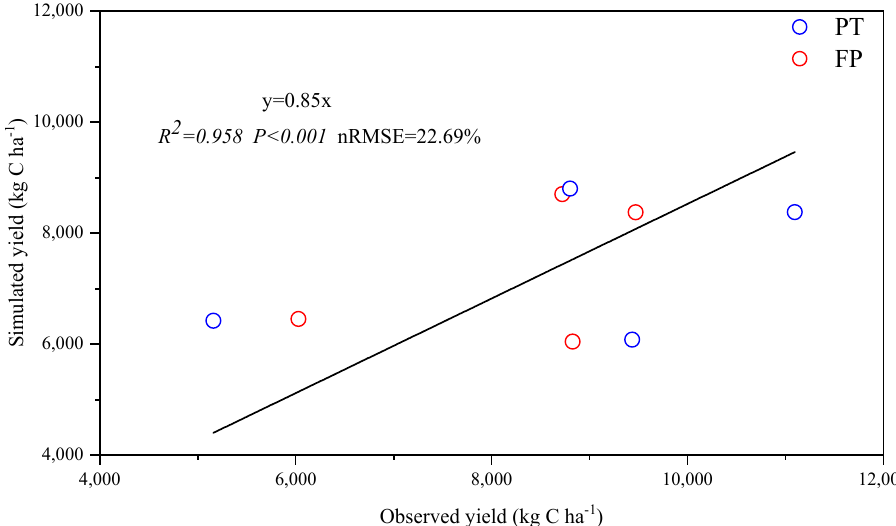
Figure 1. Comparison of simulated and observed yields during 2015 − 2017. FP represents farmers’ conventional practice, PT represents optimal practice. The modeled soil temperature data were also generally comparable with the observed values (Figure 2). The R 2 of the linear regression of simulated against observed data was 0.98, and nRMSE was 15.97%, indicating that the simulated values had high simulation reliability in the trend and range of soil temperature variation. In addition, the DNDC model overestimated the soil temperature in several periods.